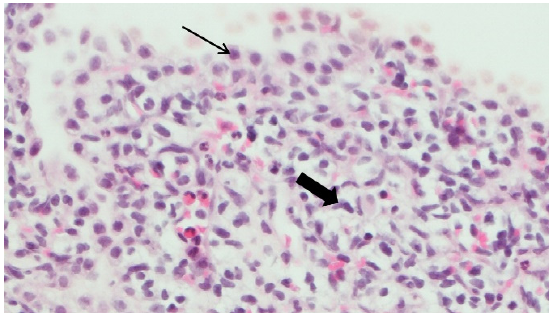
Figure 2. Pathology specimen of the cystic lung lesion in case number 1 (H&E). Alveolar cell (thin black arrow) and spindle cell (thick black arrow).